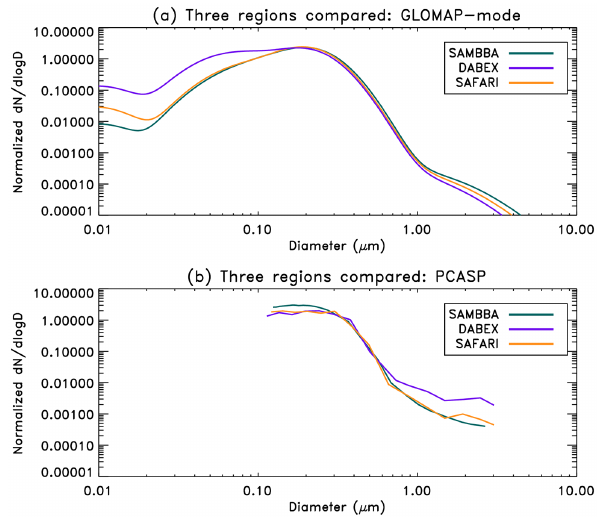
Figure 9. Same as Fig. 7 but showing only GLOMAP-mode curves and PCACP data.